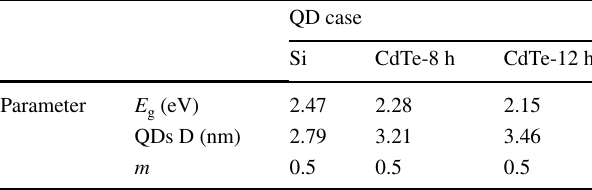
Table 1 Energy bandgap, particle diameter, and optical transition parameter value for